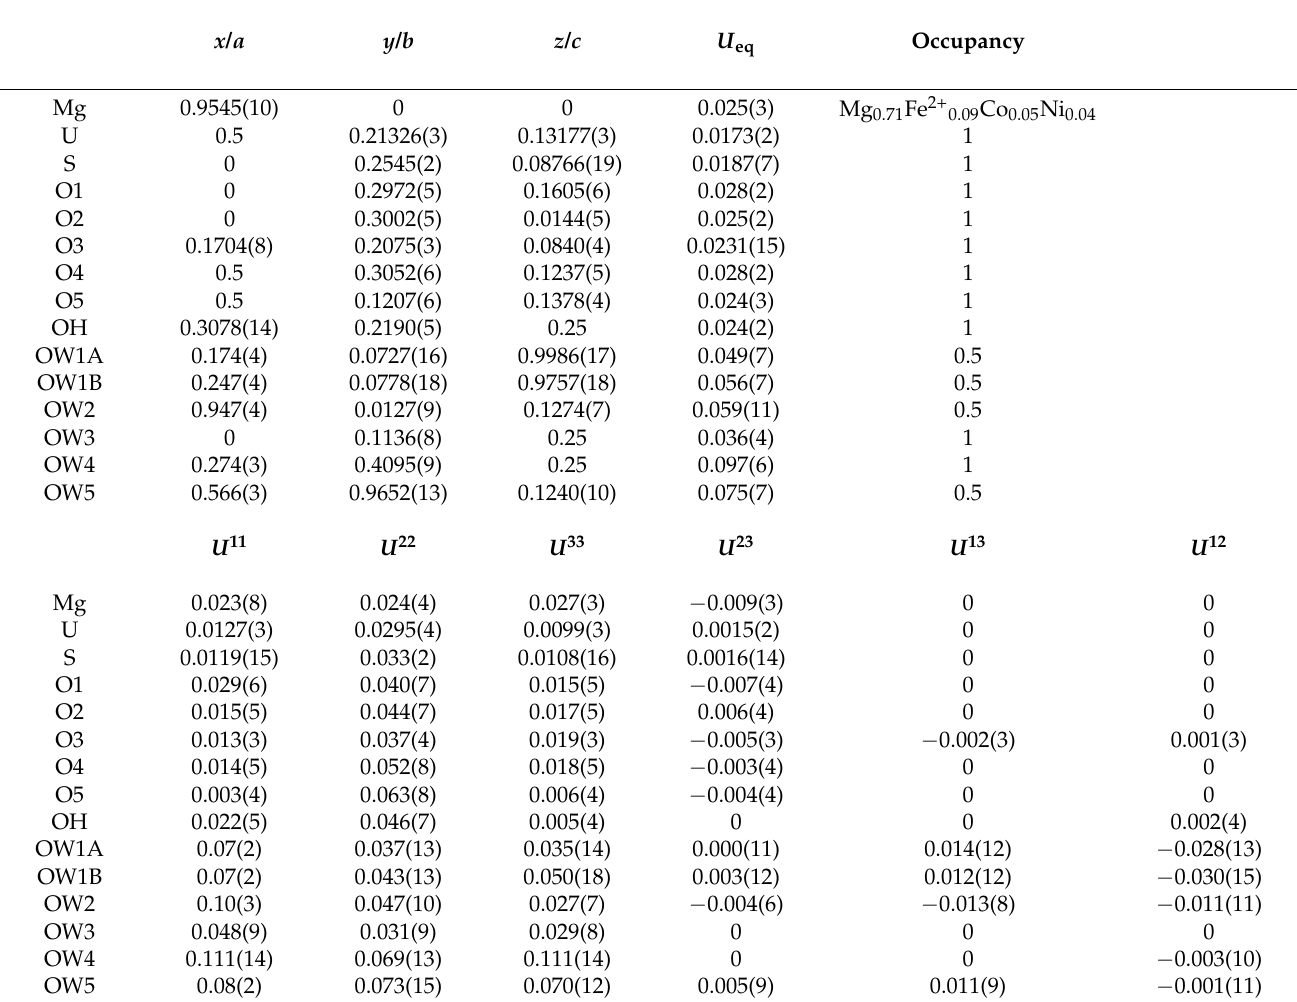
Table 4. Atom coordinates and displacement parameters (Å 2 ) for chenowethite.